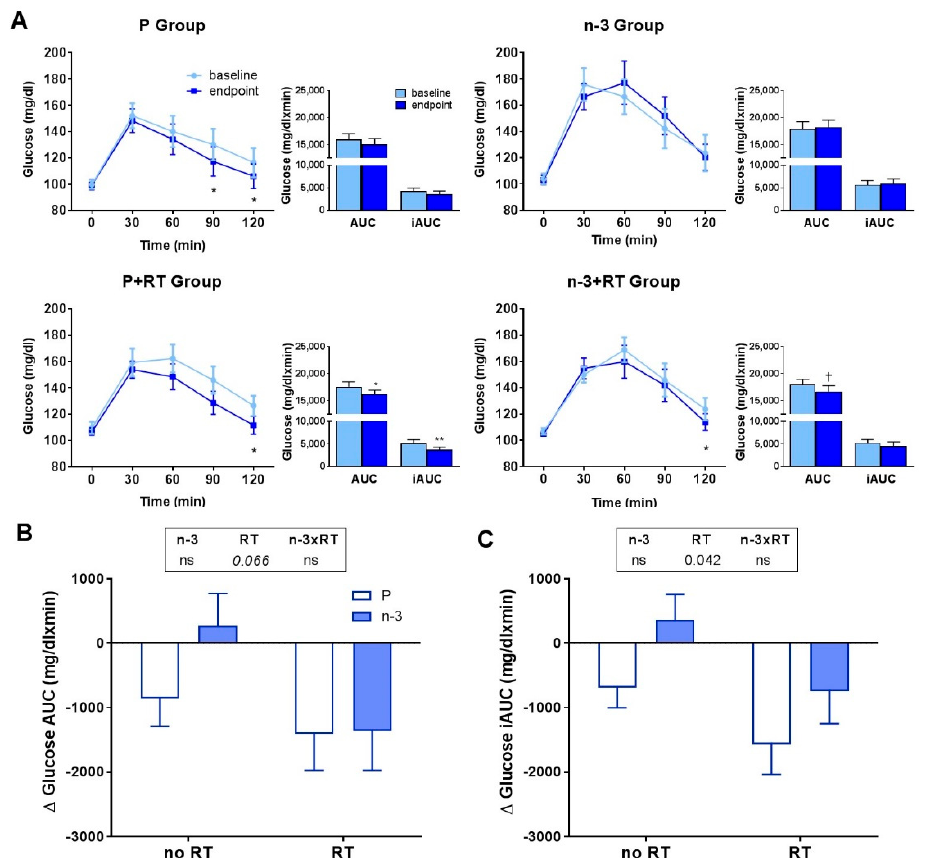
Figure 3. Effects of 16 weeks of DHA-rich n-3 PUFA (n-3) supplementation and/or resistance training (RT) on ( A ) oral glucose tolerance (OGTT) excursion curves, AUC and iAUC at baseline and endpoint, and ( B , C ) AUC and iAUC changes. Comparisons between baseline and endpoint values ( A ) were assessed using paired Student’s t-test or Wilcoxon’s signed- rank test. * p < 0.05, ** p < 0.01, † p = 0.060 vs. baseline. Comparison of changes in AUC ( B ) and iAUC ( C ) between groups was evaluated by two-way ANOVA. When a significant effect was found for one of the main factors of study, the p value was represented under the corresponding factor in the legend appearing above the graph. Factors were named as n-3 for DHA-rich n-3 PUFA supplementation, RT for exercise, and n-3xRT for the interaction between both. Statistical significance for a factor establishes a main effect for such factor on differentiating the groups it classifies (n-3: n-3-supplemented vs. P-supplemented groups; RT: RT vs. no-RT groups) according to the studied parameter (ns, nonsignificant, p > 0.05). Data are mean ± SEM. P: placebo group, n-3: DHA-rich n-3 PUFA supplemented group; P+RT: placebo + resistance training group; n-3+RT: DHA-rich n-3 PUFA supplemented + resistance training group; AUC: area under curve, iAUC: incremental